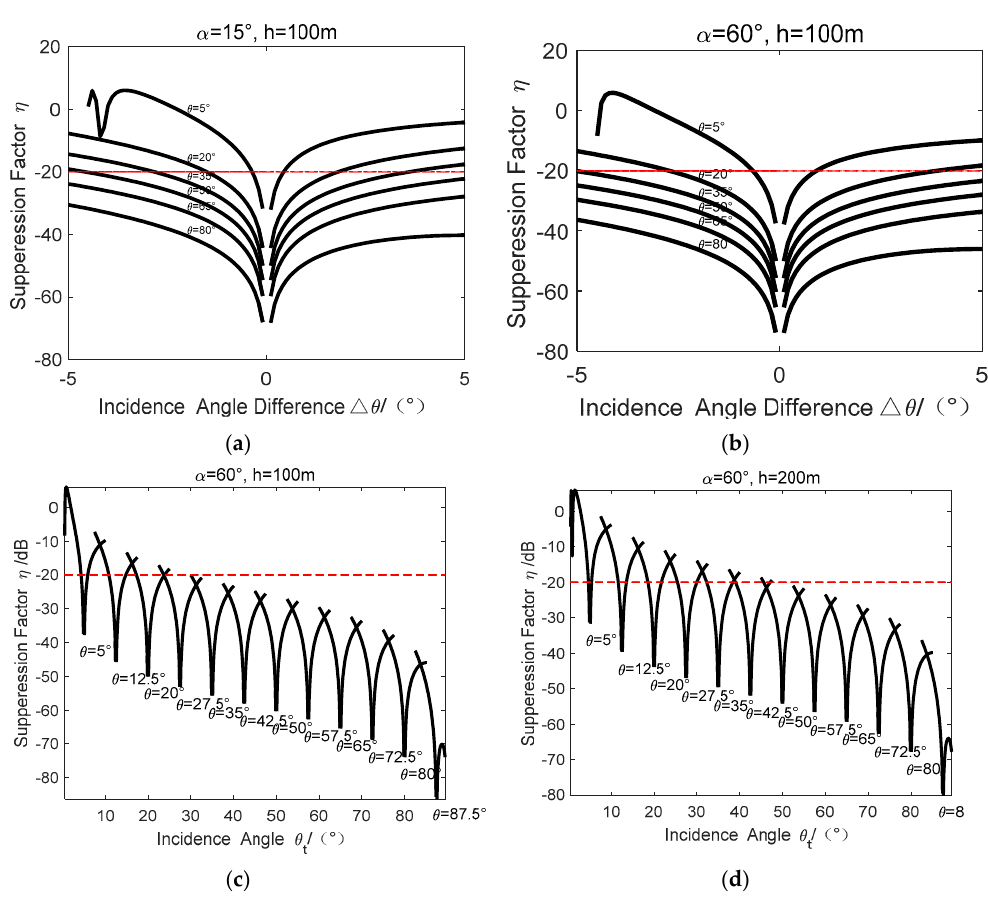
Figure 6. The suppression factor versus different system parameters. ( a ) is the suppression factor versus incidence angle difference when the target height is 100m and squint angle is 15°; ( b ) is the suppression factor versus incidence angle difference when the target height is 100m and squint angle is 60°; ( c , d ) are the suppression factor versus the incidence angle at different targets’ height. It’s found that the suppression factor becomes better with the increases of the incidence angle accordingly.